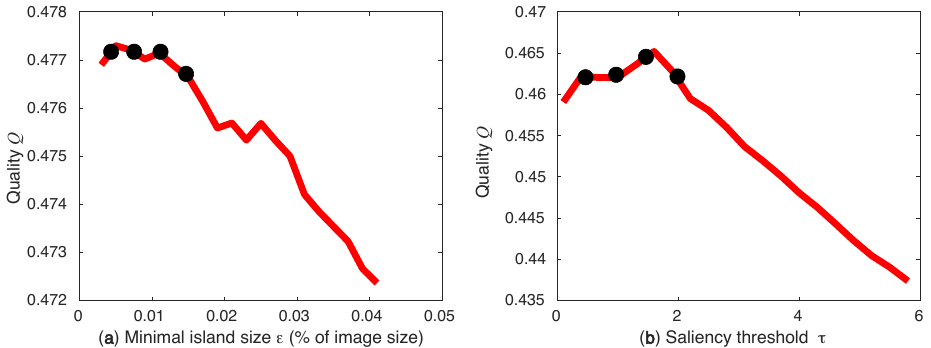
Figure 6. Quality Q as a function of island size (cid:101) ( a ) and skeleton saliency simplification τ ( a ). Selected optimal parameter values are marked